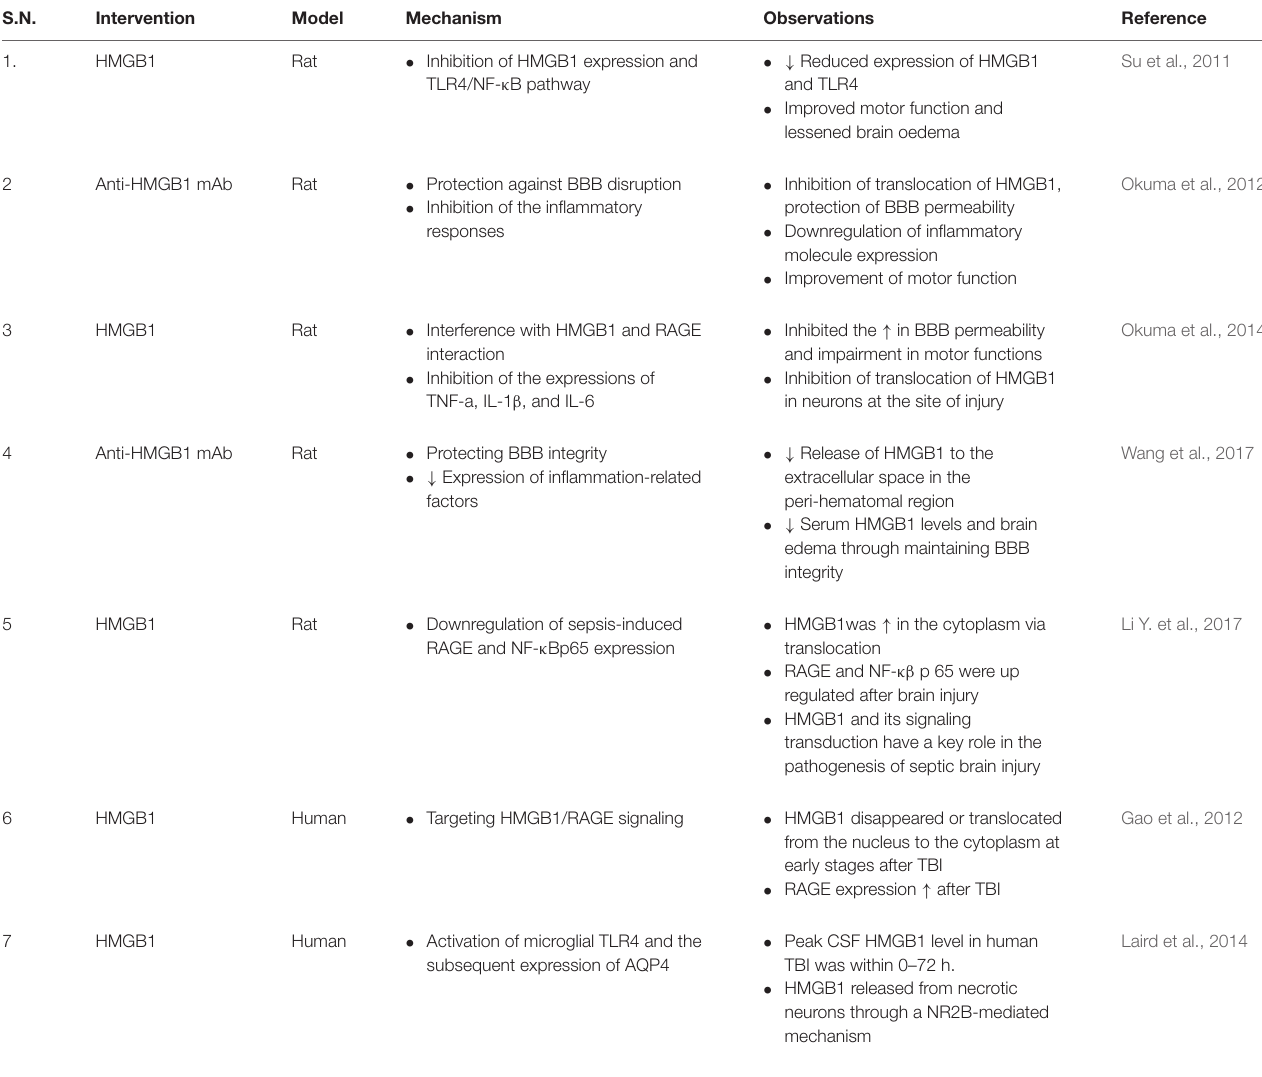
TABLE 1 | Summary of findings reporting HMGB1 in TBI.